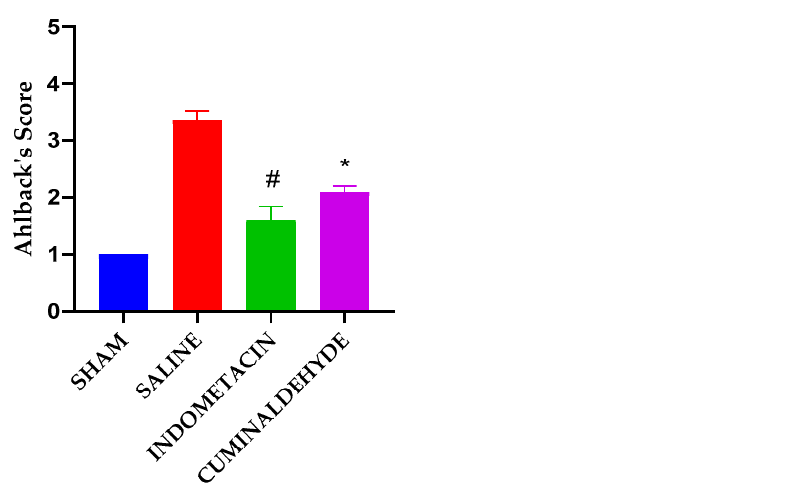
Figure 4. Degree of joint involvement in rats treated with cuminaldehyde, following the Alhback’s Score Data are represented as means ± standard error of the means (SEM). This analysis was performed with the knees collected on day 29 after OA induction. * Significant differences at p < 0.05 compared to CTRL (-) group (saline); # Significant differences at p < 0.05 compared to cuminaldehyde group. (one-way ANOVA; Dunnett).